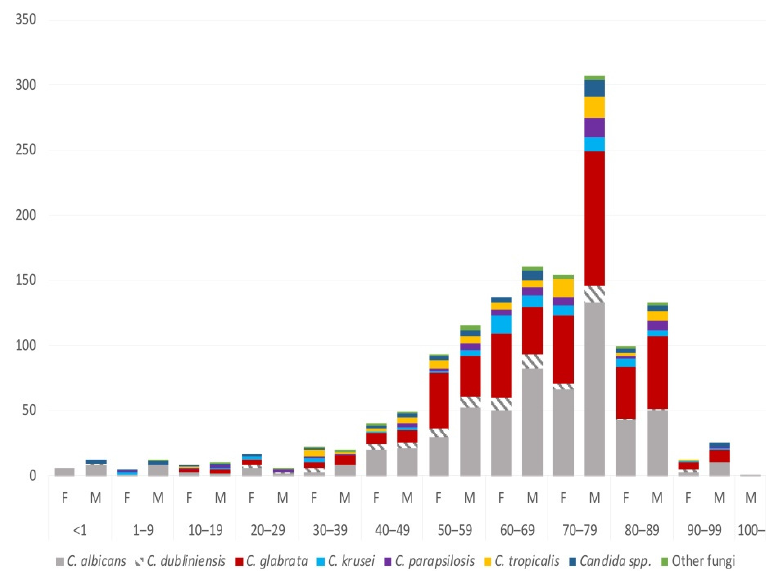
Figure 1. Number of isolates according to age and gender in 2016 to 2018. Table 1. Population and patient demographics, episode rates, and species distribution.